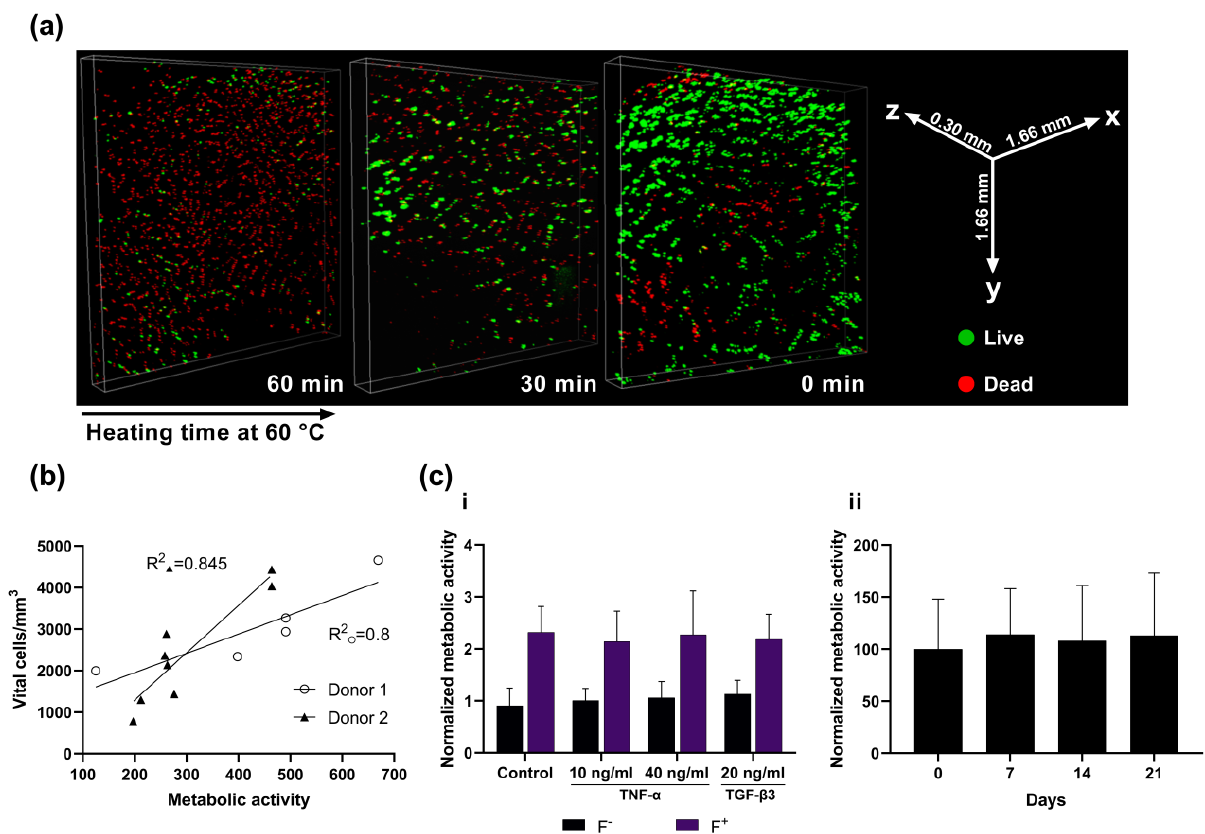
Figure 1. Viability analysis of osteochondral live slices. ( a ) Confocal laser scanning microscopy of slices at three weeks of culture following heating at 60 ◦ C for 0, 30 or 60 min and live/dead staining with PI/FDA. Vital cells appear green, while dead cells appear red. ( b ) Correlation analysis of vital cell count as determined by CLSM and metabolic activity as determined by AlamarBlue resazurin assay. Two donors and a total of 13 slices with varying viability were analyzed and revealed correlation coefficients of 0.8 and 0.845. ( c ) Resazurin assay results with and without additional stimulation. i: Viability of slices on day 7 relative to day 0. Slices were stimulated with 10 or 40 ng/mL TNF- α or with 20 ng/mL TGF- β 3, and either with or without FBS. ii: Viability of slices without FBS or other stimulating factors over 21 days, relative to day 0.